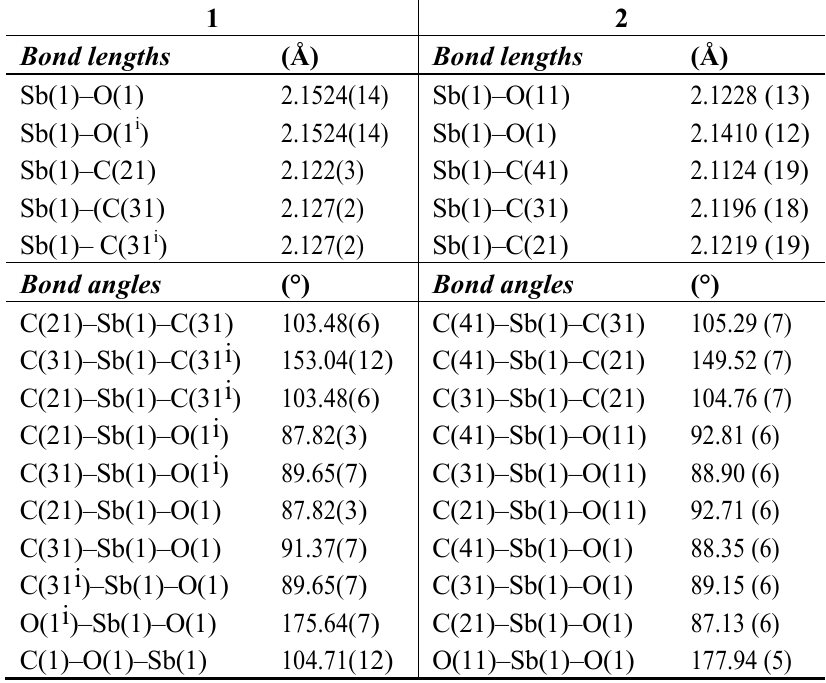
Table 2. Selected bond lengths (Å) and bond angles (°) for 1 and 2